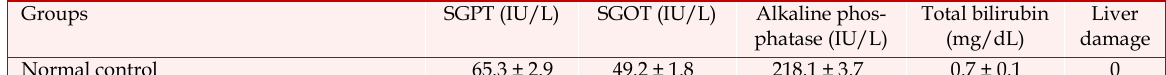
Effects of ethanolic extract of C. murale (whole plant) on rabbits serum biochemical parameters after carbon tetrachloride